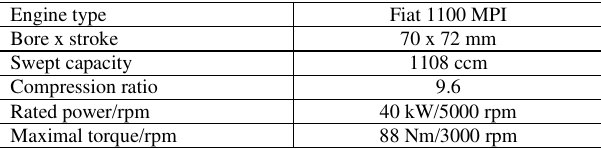
Table 1. Technical data of the Fiat 1100 MPI engine